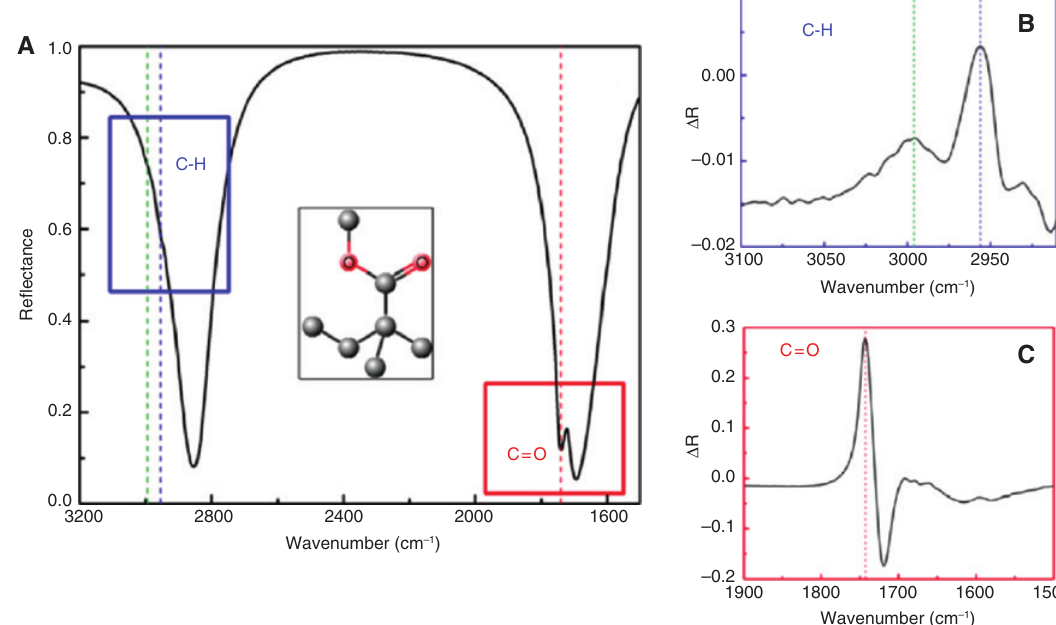
Figure 19: SEIRA spectroscopy of PMMA on the absorber. (A) Reflectance spectrum of the absorber after the coating of a 4 nm-thick PMMA film. Characteristic vibrational stretches of C = O and C-H are visible on the spectrum as indicated by the dashed lines. The inset shows the repeat unit of PMMA polymer. (B) Reflectance difference spectrum of the C-H group and (C) C = O band. Reprinted with permission from Ref. [133]. Copyright 2012 American Chemical